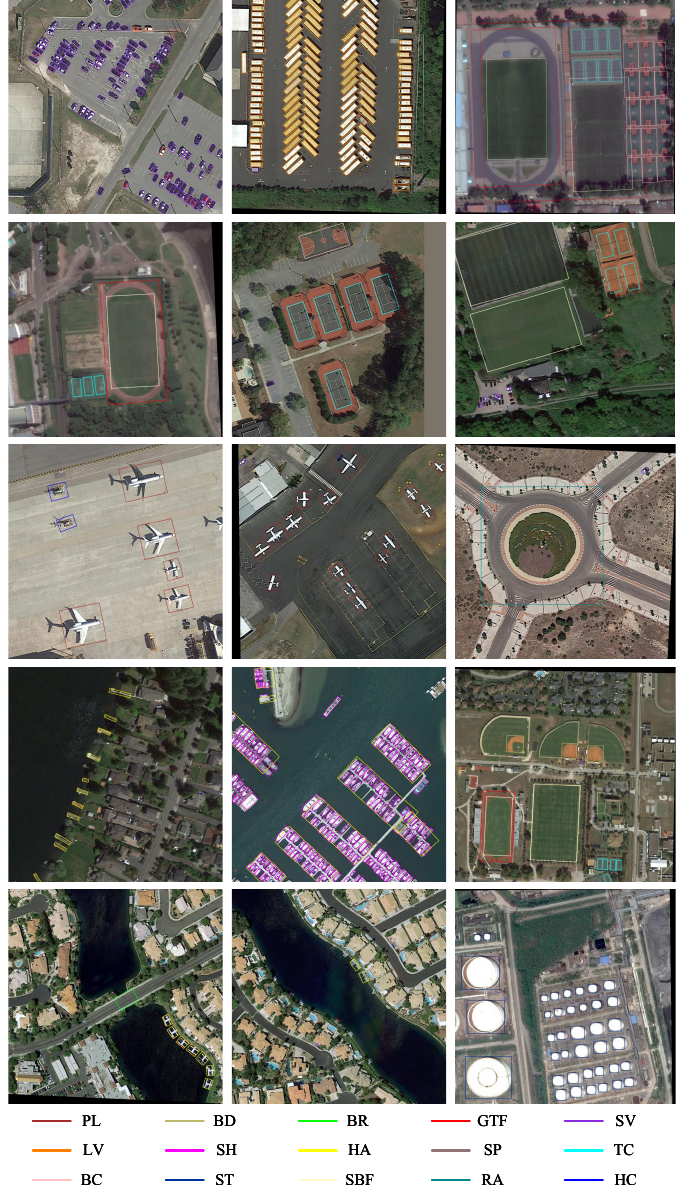
Figure 7. Visualization of the example detection results on DOTA testing